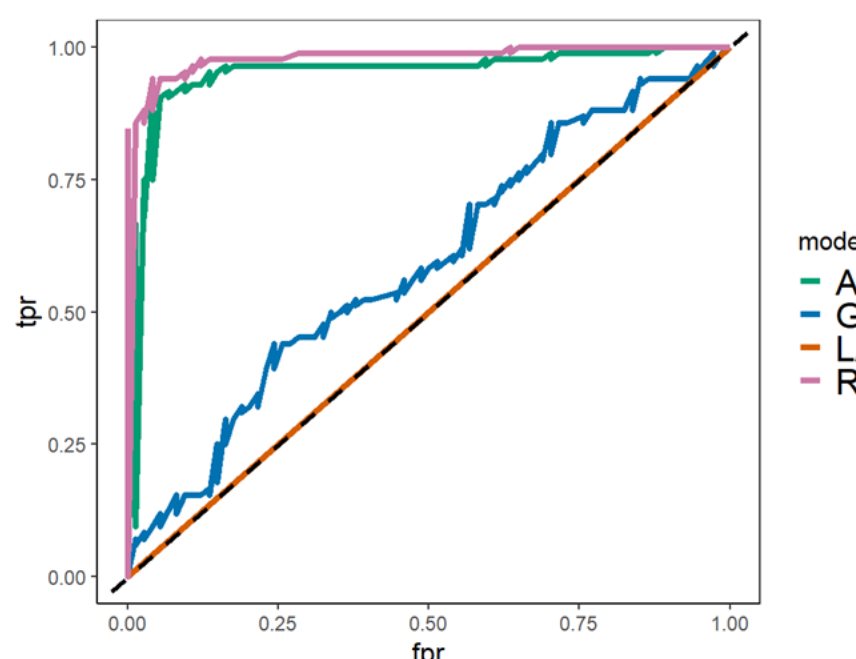
Figure 3. The area under the receiver operating characteristic (ROC) curve (AUC) of the considered models. False-positive rate (fpr) and true-negative rate (tpr) were considered. The plot shows the ROC curves calculated for each classifier over the entire dataset. RF and NN offer the best performance. Abbreviations: LASSO, LASSO–RIDGE regression; GBM, gradient boosting machine; ANN, artificial neural network; RF, random forest.